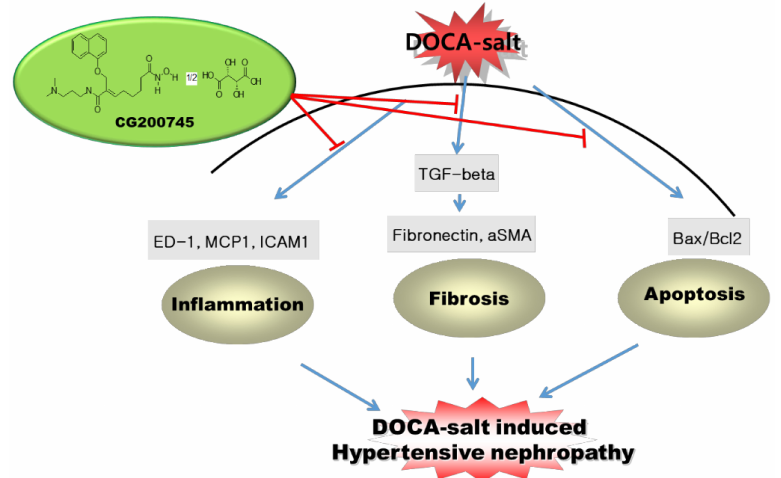
Figure 9. Schematic representation of the main findings of the